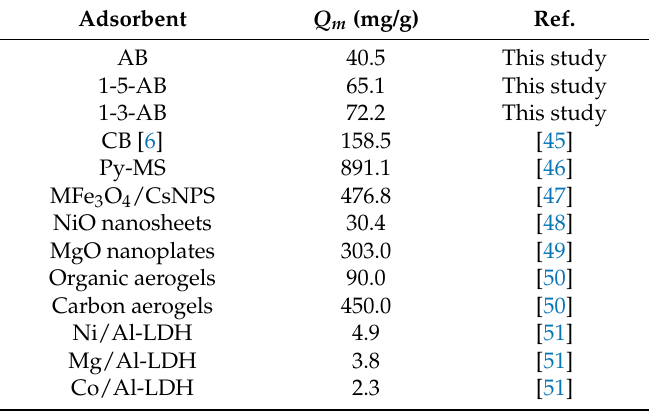
Table 4. Comparison of the maximum adsorption capacities ( Q m ) of RBR on different